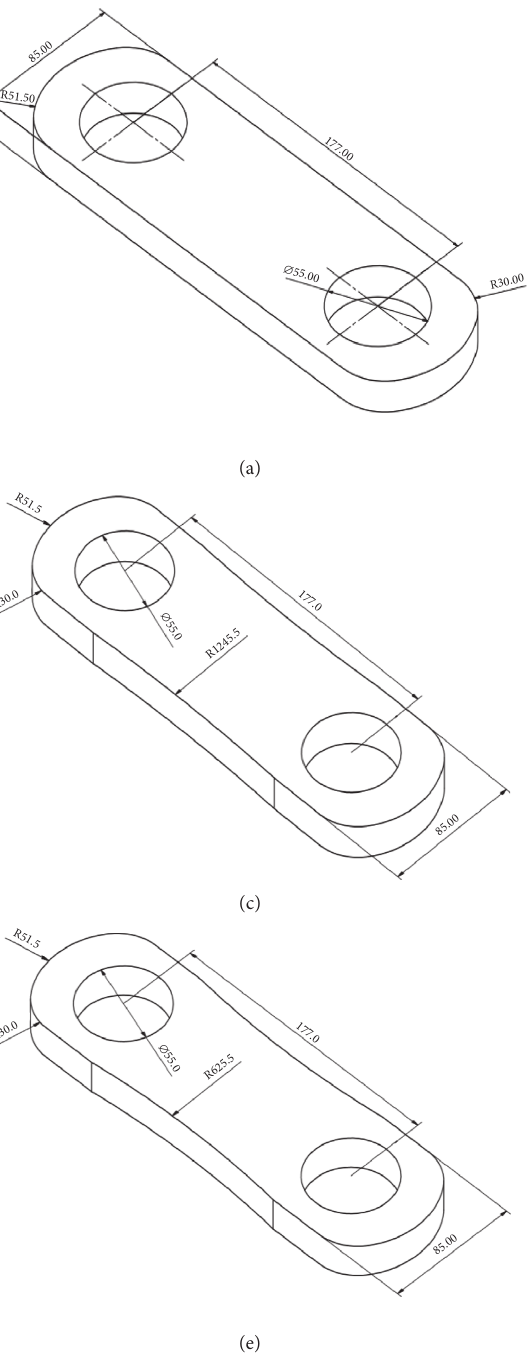
Figure 2: Conveyor chain link models: (a) X � 0mm, (b) X � 5mm, (c) X � 4mm, (d) X � 3mm, (e) X � 2mm, and (f) X � 1mm.